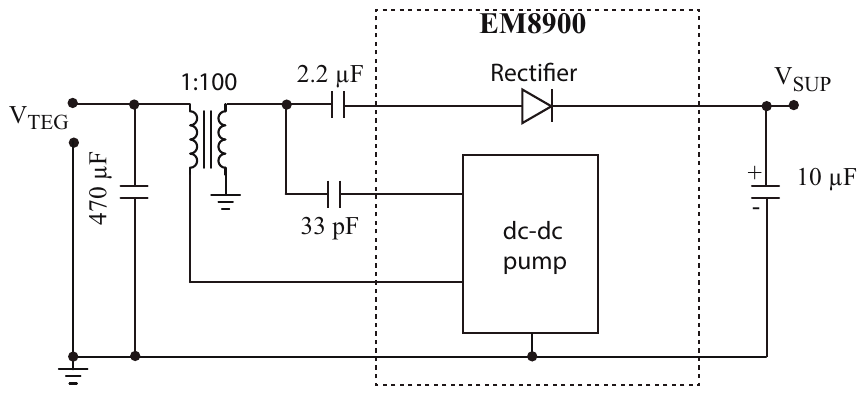
Figure 2. Implemented DC–DC converter using the